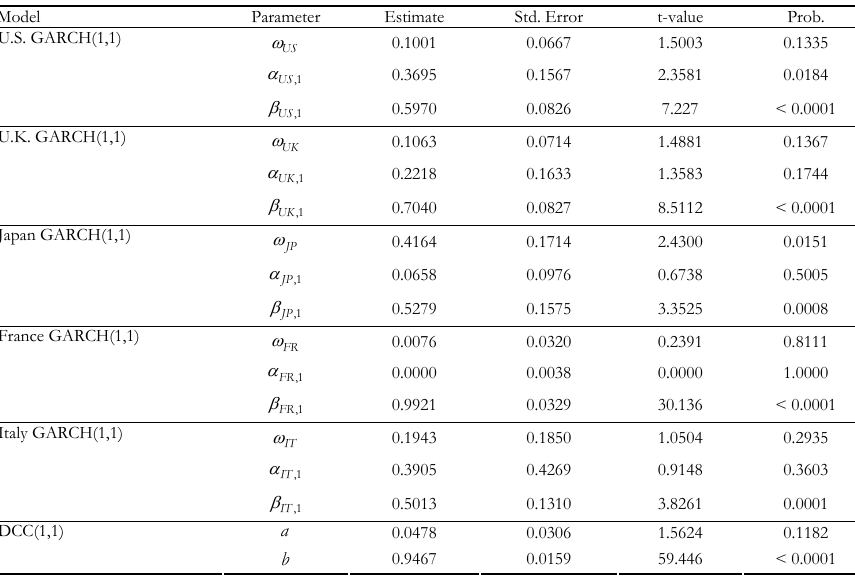
Results of coefficient estimates for DCC MV-GARCH